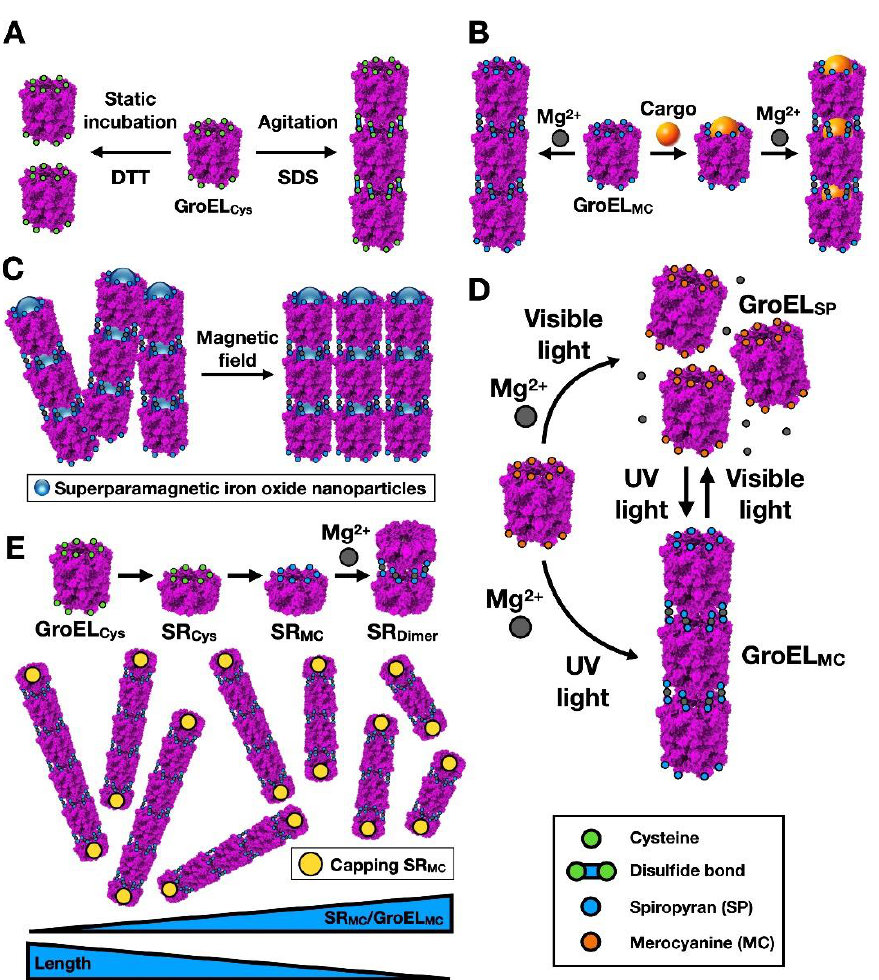
Figure 5. High-order Type I chaperonins for nanotechnological purposes. ( A ) Scheme of the for- mation of nanofibers using modified GroEL, as described in [35]. A Cys residue (green ball) is placed within the apical domain of the chaperonin, and filaments are formed via disulfide bonds. Filament formation and disassembly is controlled by the redox conditions of the medium. ( B ) Scheme showing the generation of tubular containers based on chemically treated GroEL mutants, according to [36]. A Cys residue (green) was inserted into the apical domains of the chaperonin GroEL, which allows binding of 1 ′ -(maleimidoethyl)spirobenzopyran. Mg 2+ induces oligomerization of the GroEL cylinders, which can store the cargo (orange sphere) in the locked cavity. ( C ) Illustration of the magneto-induced, lateral assembly of GroEL filaments containing superparamagnetic particles [37]. ( D ) Cartoon depicting the light-induced assembly/disassembly of nanotubes, as described in [39]. ( E ) Top, scheme of the synthesis of the single-ring, merocyanine-modified GroEL version (SR MC ) and the Mg 2+ -mediated dimer formation. Bottom, filament formation of the MC-modified, two-ring GroEL version, whose length can be limited by the presence of the SR MC version [40]. The same authors have gone even further, using superparamagnetic nanoparticles (SNPs) made of iron oxide as a cargo, which can be chemically modified to become